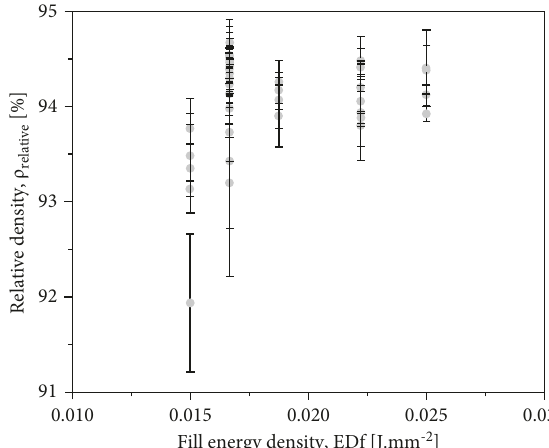
Figure 3: Effect of fill energy density on the relative